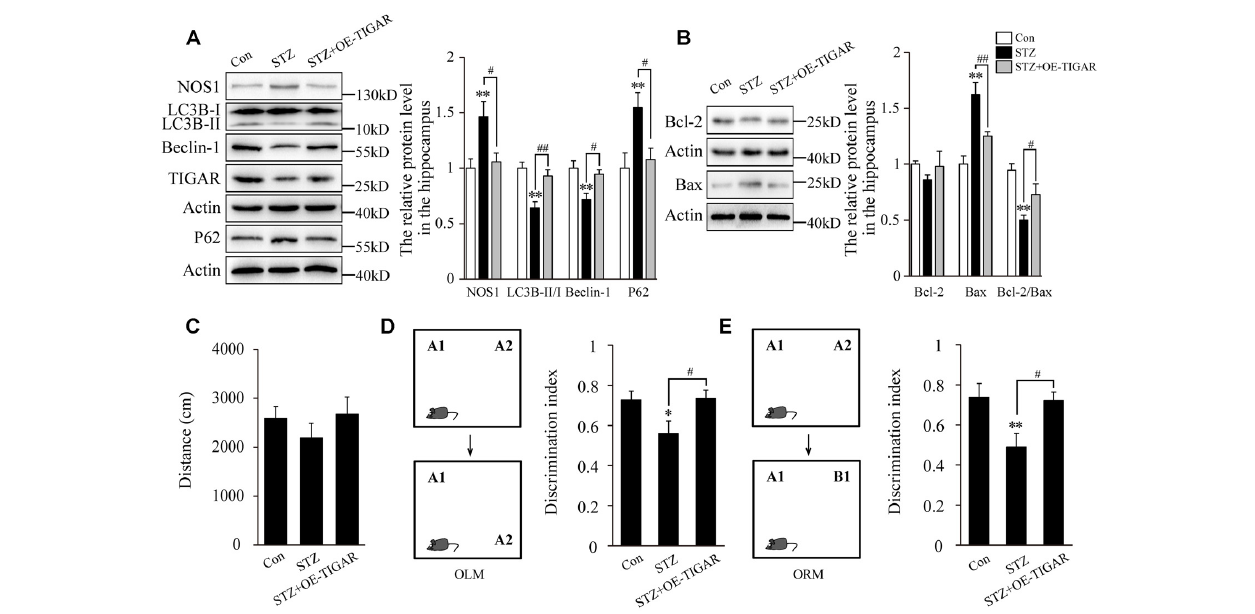
FIGURE 5 | Overexpression of TIGAR reduced STZ-induced autophagy impairment and memory loss in mice. (A) Western blot analysis of NOS1, LC3B, Beclin-1, TIGAR and P62 after intraperitoneal injection of STZ and microinjection of Lenti-TIGAR in the hippocampus of mice ( n = 5 per group). (B) Western blot analysis of Bcl-2 and Bax in the hippocampus of each group ( n = 5 per group). (C) Locomotor activity was quantified 4 weeks after microinjection of Lenti-GFP or Lenti-TIGAR into the hippocampus of mice ( n = 7 per group). (D) Schematic representation of the location-dependent object recognition memory (ORM) test (Left). Quantification of discrimination index in each group ( n = 7 per group; Right). (E) Schematic representation of the novel ORM test (Left). Quantification of discrimination index in each group ( n = 7 per group; Right). ∗ p < 0.05, ∗∗ p < 0.01 vs. the control group, # p < 0.05, ## p < 0.01 vs. the STZ group, one-way